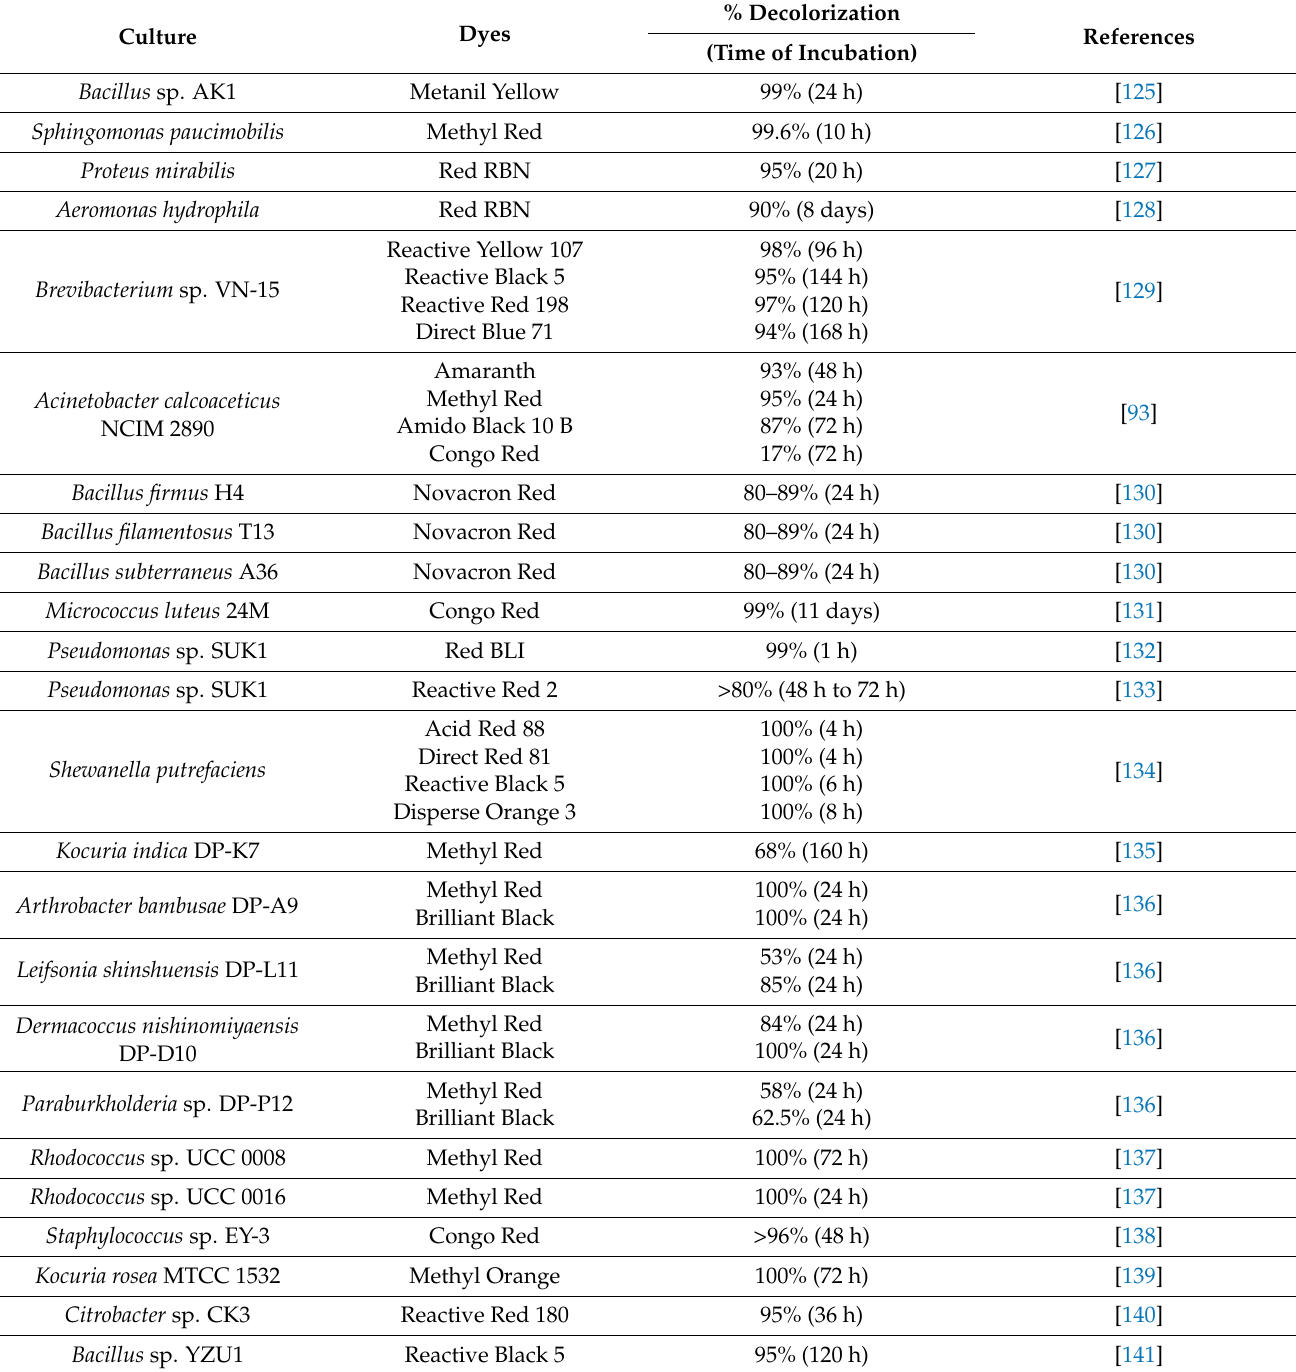
Table 2. List of single bacterial cultures used on different dye decolorization